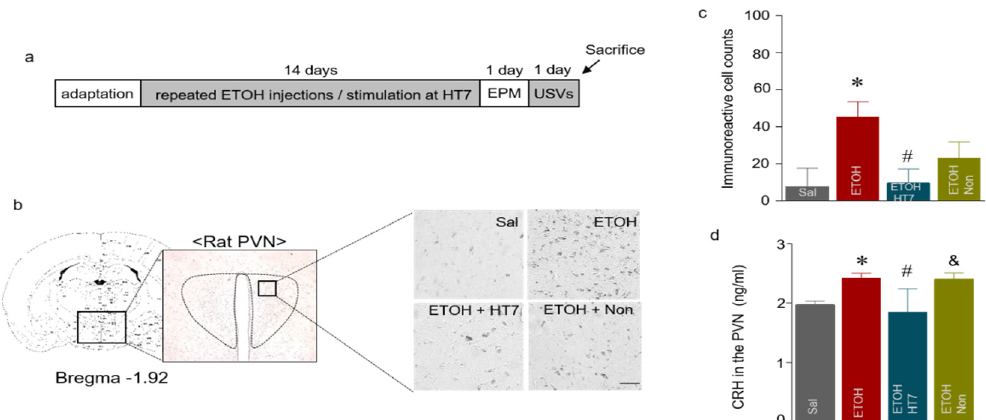
Figure 6. Schematic showing the acupuncture stimulation and sacrifice schedule ( a ). Representative micrographs showing the expression of corticotropin-releasing hormone (CRH) in the paraventricular nucleus (PVN). The scale bar represents 100 µ m ( b ). The results are presented as the number of CRH-immunoreactive cells (n = 5–7 rats per group) ( c ). CRH levels in the PVN (n = 4–6 rats per group) ( d ). The data were analyzed using repeated measures ANOVA followed by Tukey’s test. * p < 0.05 compared with the Sal group, # p < 0.05 compared with the ETOH group, and & p < 0.05 compared with the ETOH + HT7 group. Values are presented as means ± SEM.